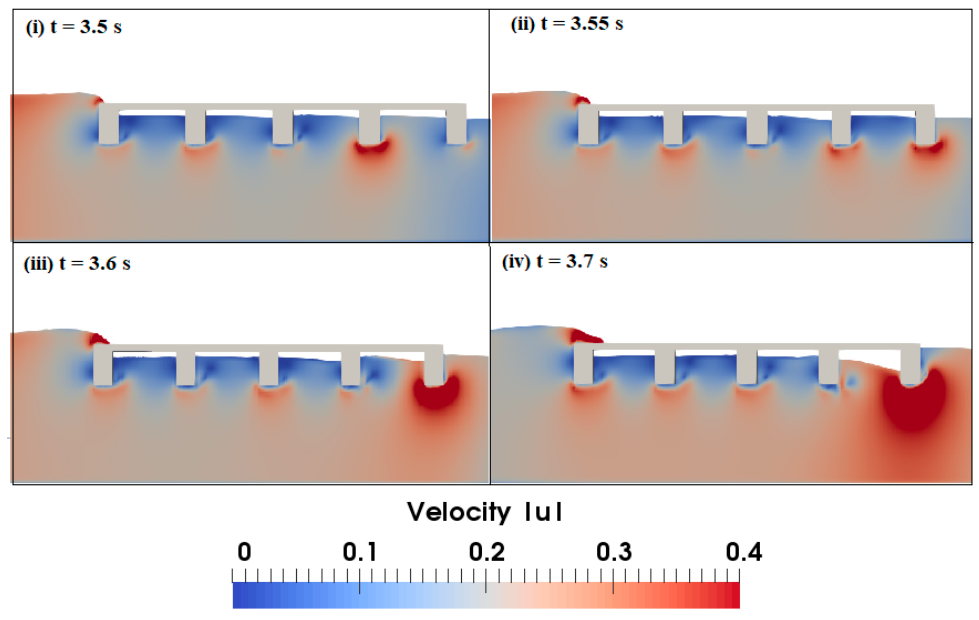
Figure 7. Color contour maps showing the variation of velocity (m/s) at different time steps during the solitary wave impact on the deck.